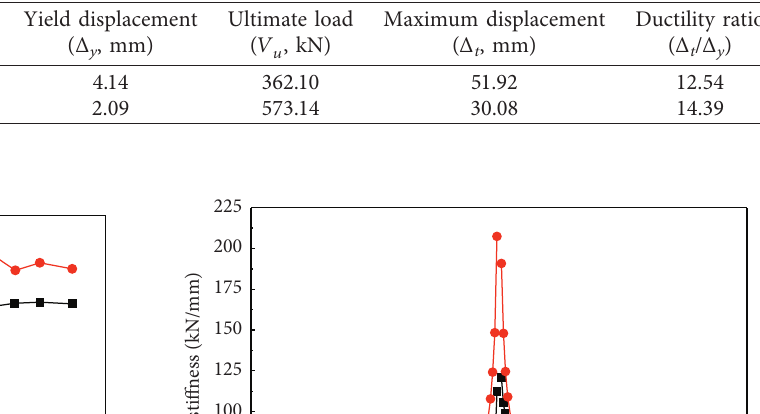
Table 8: Hysteretic behavior of test specimens.